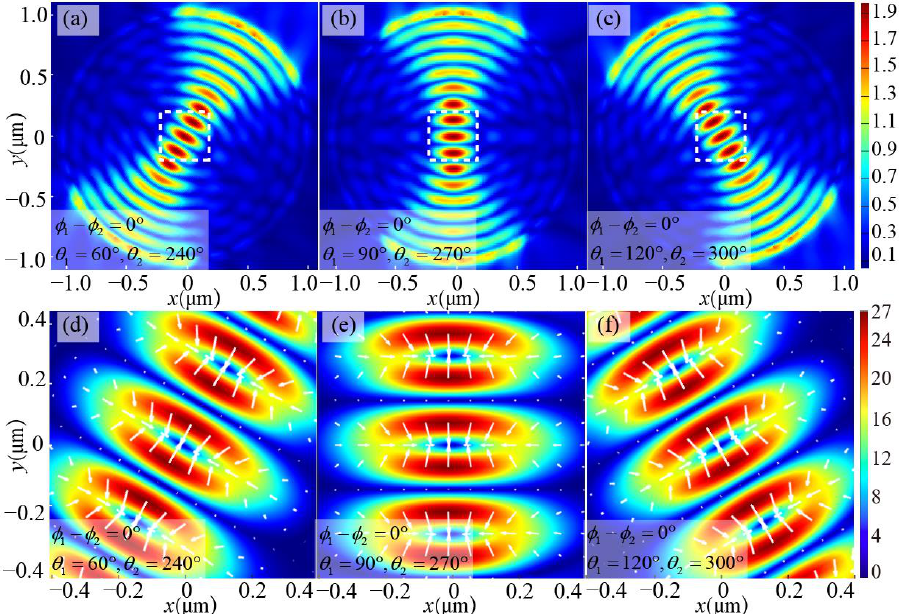
Figure 3. Different electric field ( a – c ) and optical force ( d – f ) distributions when changing the angle of the incident beams. the incident